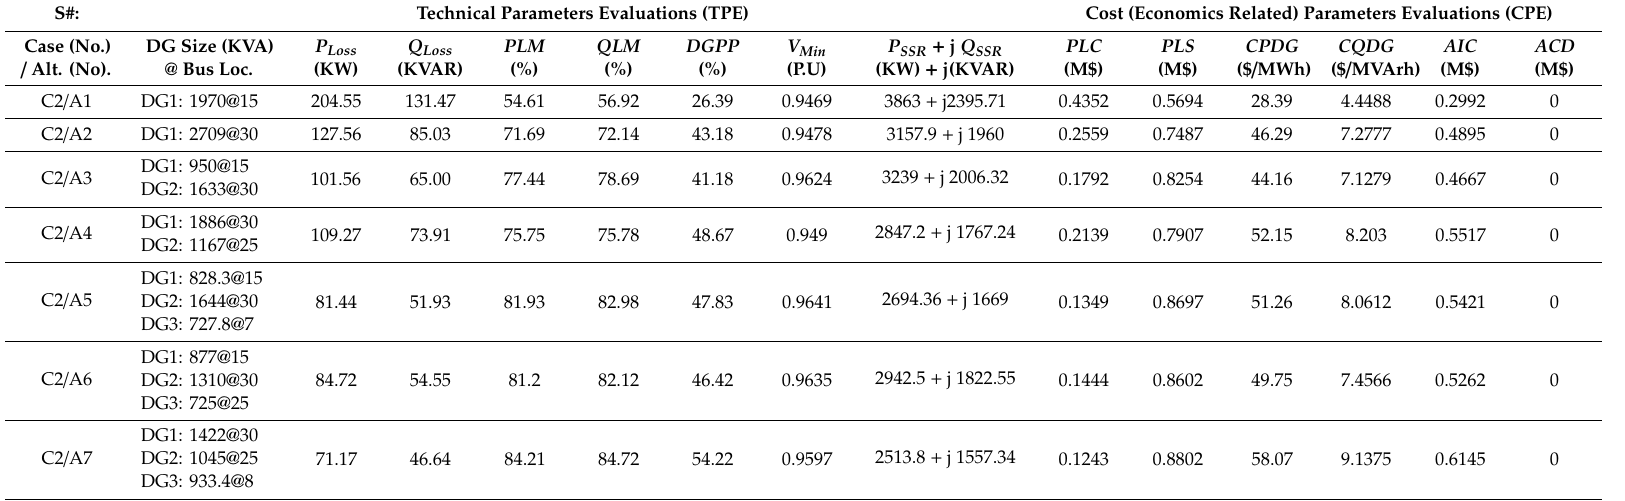
Table 15. Techno-economic evaluation analysis in case 2 (C2_LG) for 33-bus